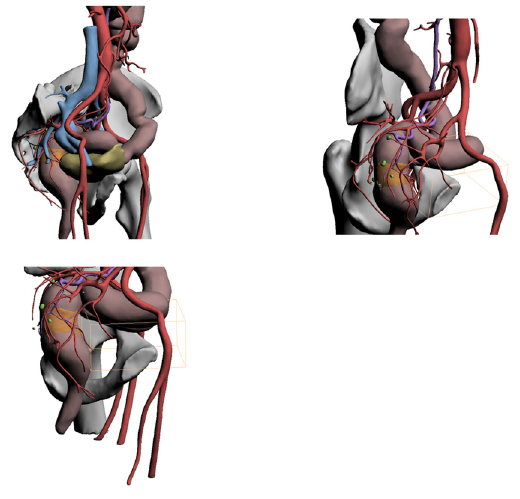
Figure 9. 3D reconstruction (Case 5).